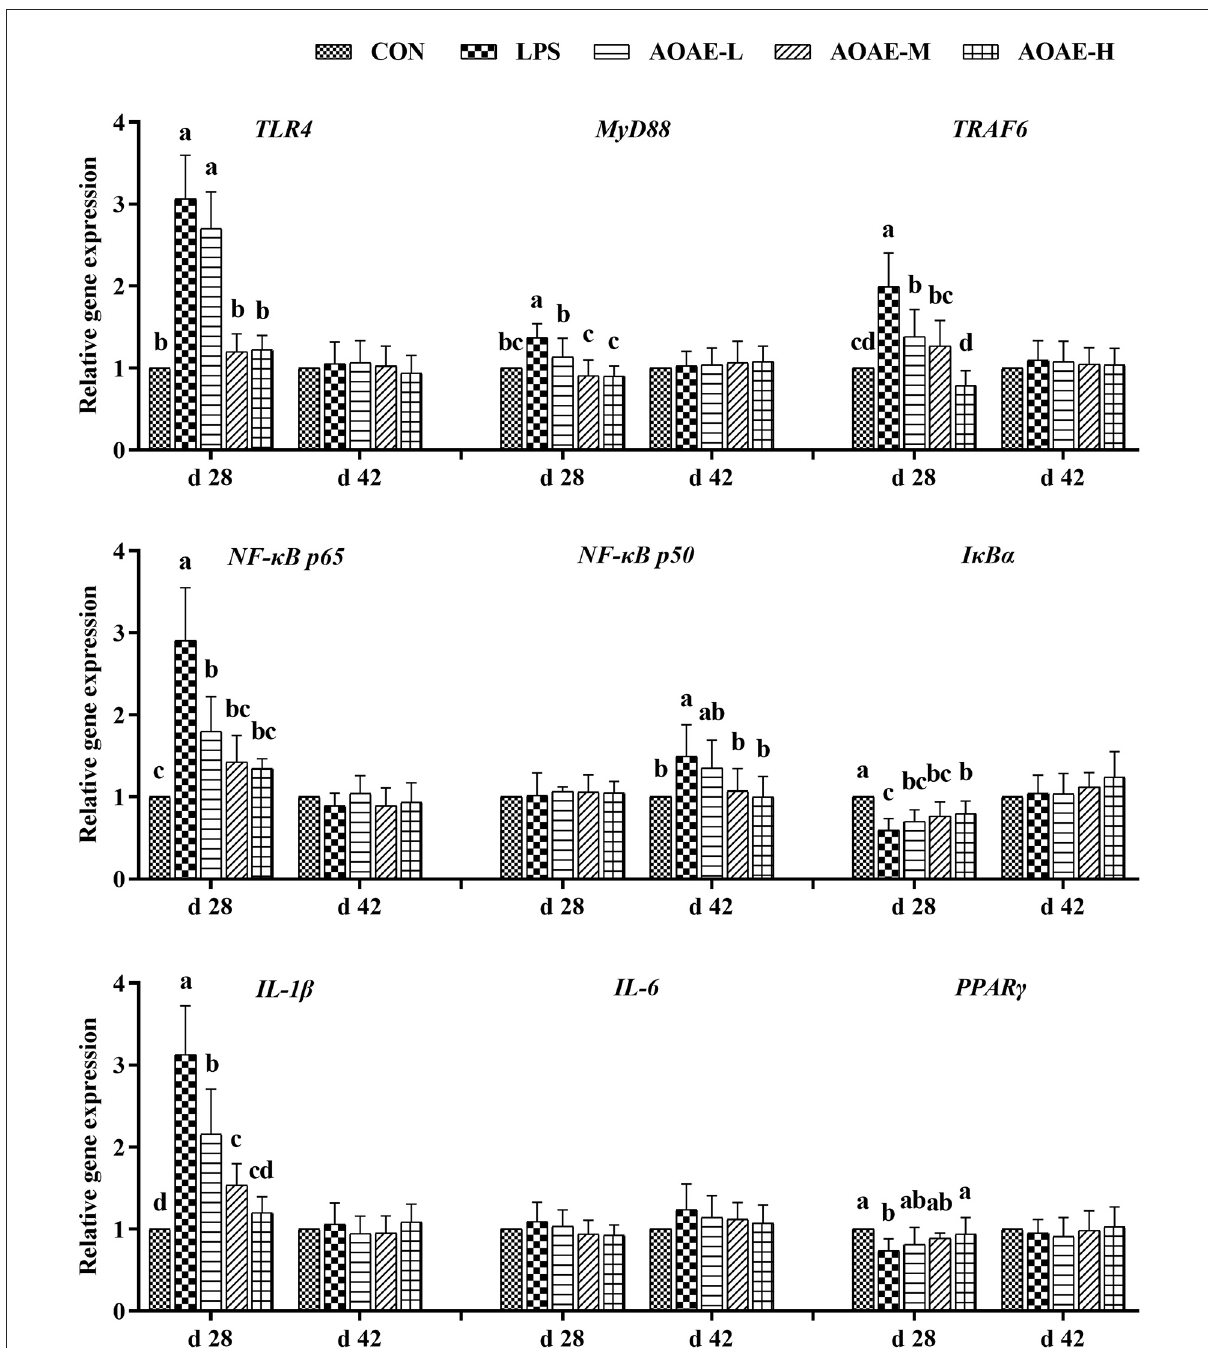
FIGURE1 Effect of AOAE on the expression of TLR4/NF- κ B pathway related genes in liver of broilers challenged with LPS (1) TLR4, toll like receptor 4; MyD88, myeloid differentiation factor 88; TRAF6, tumor necrosis factor receptor associated factor 6; NF- κ B p65, nuclear factor kappa B p65; NF- κ B p50, nuclear factor kappa B p50; I κ B α , inhibitor of NF- κ B alpha; IL-1 β , interleukin 1 beta; IL-6, interleukin 6; PPAR γ , peroxisome proliferator-activated receptor γ . (2) AOAE, Artemisia ordosica alcohol extract; CON, non-challenged broilers fed a basal diet; LPS, lipopolysaccharide-challenged broilers fed a basal diet; AOAE-L, lipopolysaccharide-challenged broilers fed a basal diet supplemented with 500 mg/kg AOAE; AOAE-M, lipopolysaccharide-challenged broilers fed a basal diet supplemented with 750 mg/kg AOAE; AOAE-H, lipopolysaccharide-challenged broilers fed a basal diet supplemented with 1,000 mg/kg AOAE. (3) The gene expression for β -actin was used as a housekeeping gene. The relative expression levels from the control group were used as reference values. Each value is shown as mean ± SD (n = 6). Bars that do not share the same letters (a, b, c, and d) are significantly different ( P < 0.05) from each